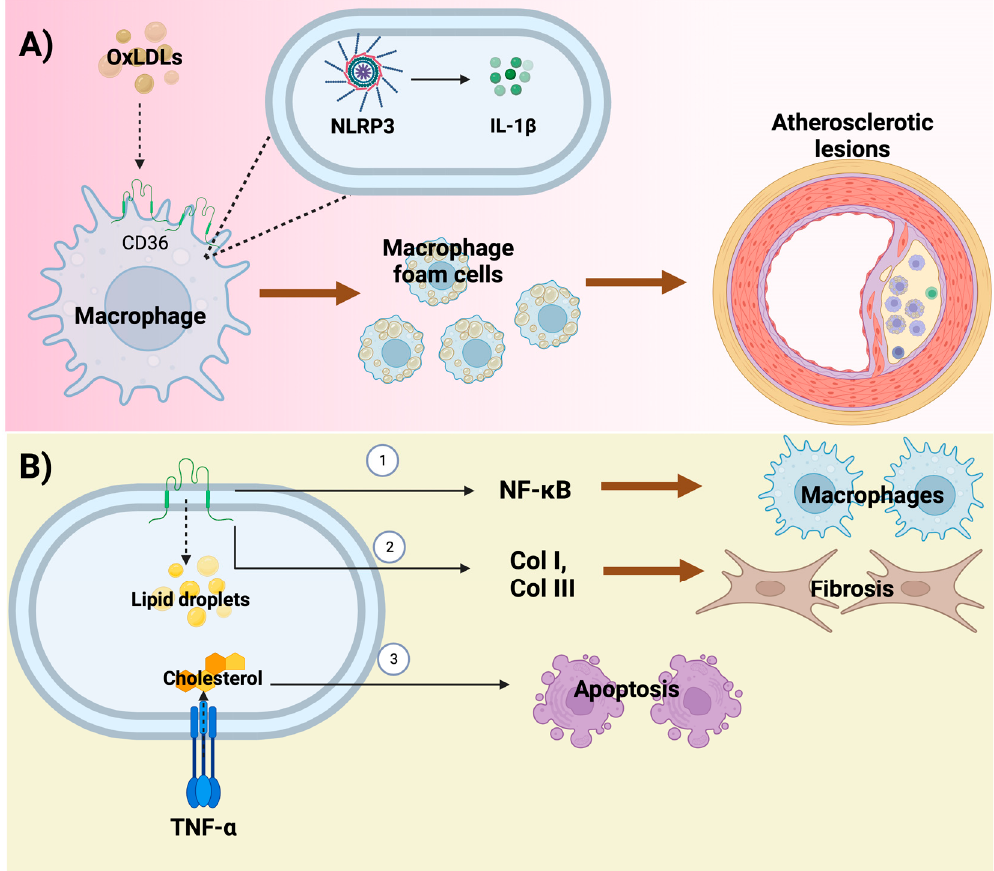
Figure 2. Effect of inflammation and fibrosis in chronic kidney disease (CKD)-induced dyslipidemia.